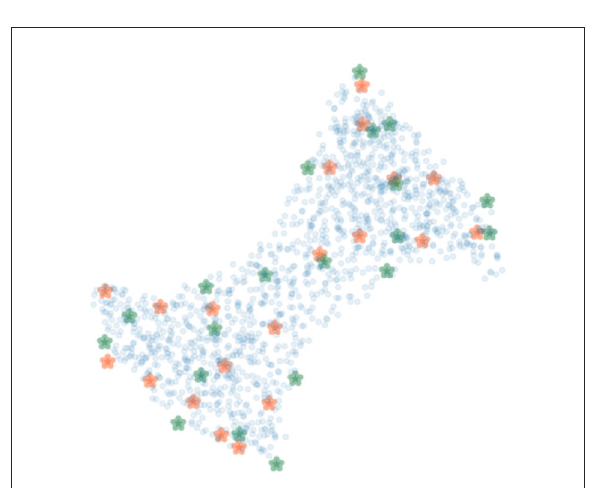
FIGURE7 The bounding (green) and SIFT (orange) landmarks of a bone with random bone voxels in blue. The landmarks are distinguishable and at a distinctive distance from each